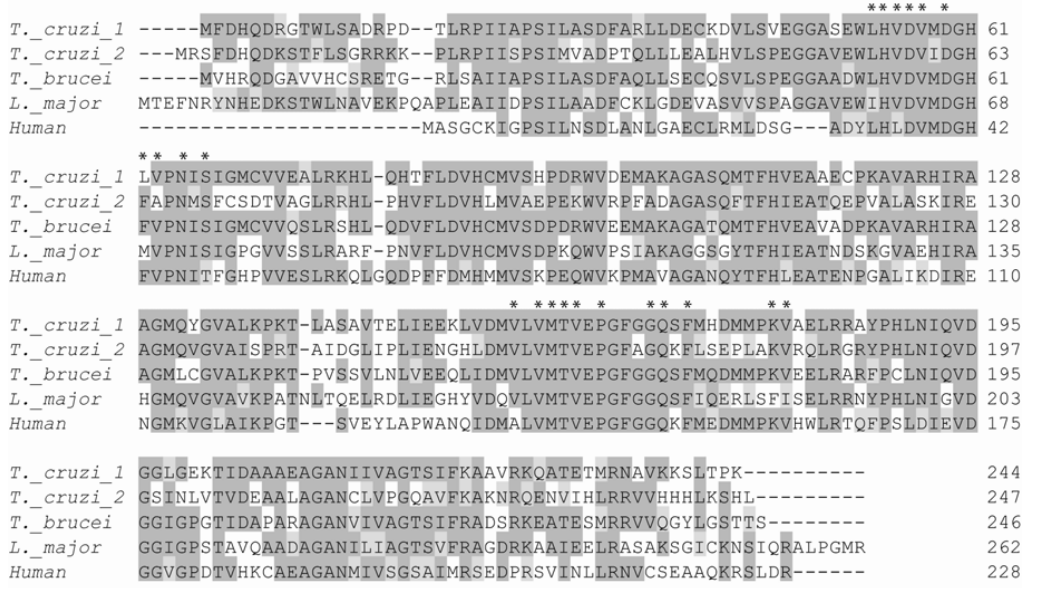
Fig. 6 – Alignment of the deduced amino acid sequences of different ribulose 5-phosphate epimerases. The two epimerases from T. cruzi (TcRPE1, EU075265 and TcRPE2, EU075366) are aligned with those of T. brucei (XP_823426), L. major (CAJ06401) and human (NP_954699). Tc Rpe2 presents a PTS 1 (SHL) in the C-terminus. The asterisks indicate the residues conserved in the RPE signature.